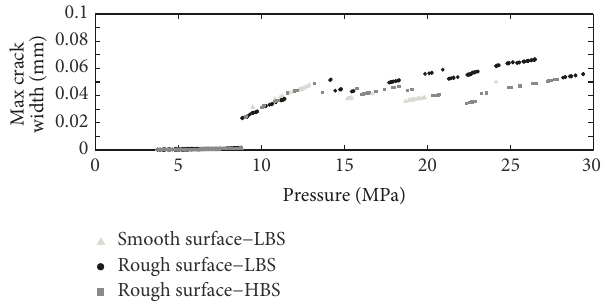
Figure 16: Influence of interface strength and substrate surface roughness on imposed internal pressure and corresponding maxi- mum crack widths prior to repair system failure. SHCC is used as a repair material (LBS corresponds to interface strength 1MPa and HBS to interface strength of